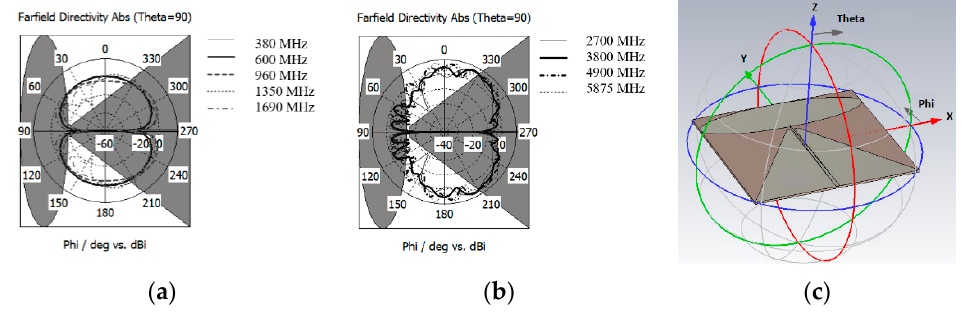
Figure 4. The simulated azimuth radiation pattern (Theta = 90° plane) of the elliptical monopole with trapezoid ground plane lied at the horizontal plane for the frequency range of ( a ) 350–1690 MHz and ( b ) 2700–5875 MHz. ( c ) The coordinate system of the model.